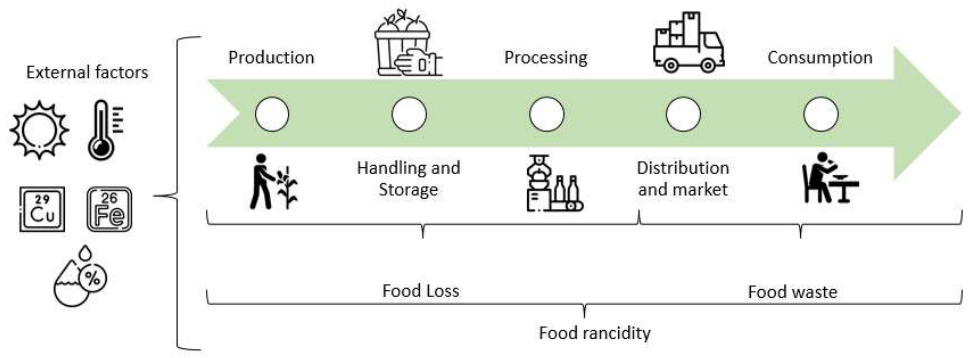
Figure 1. Environmental stressors triggering rancidity at different stages of food production.